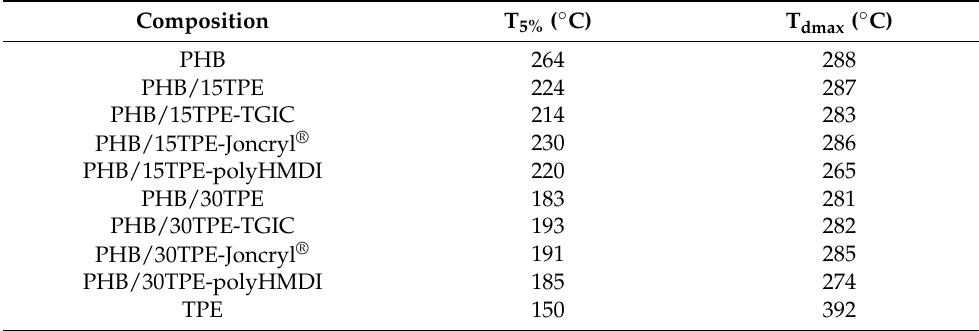
Table 5. TGA data of PHB, TPE, and PHB/TPE 15 and 30 wt% with and without compatibilizers blends.